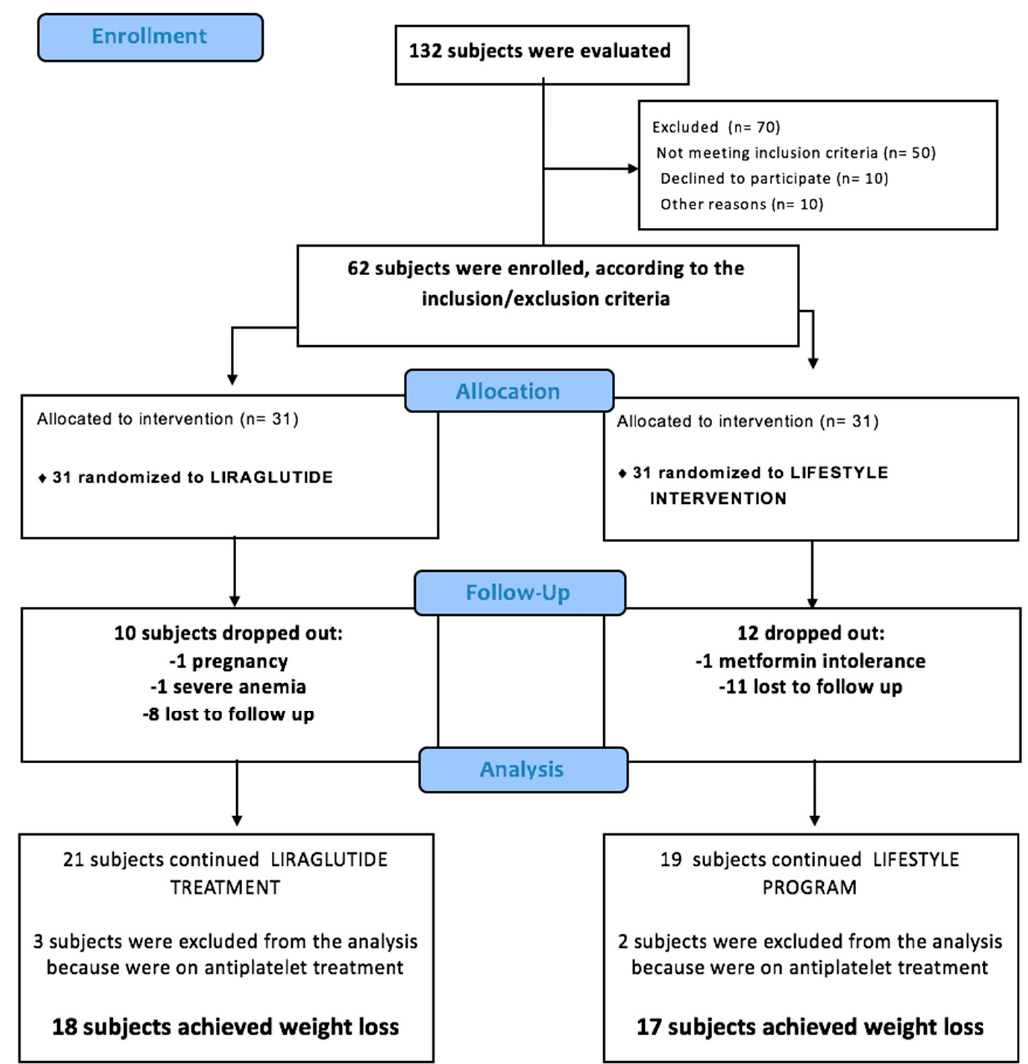
Figure 1. Flow diagram of the patients included in the study.